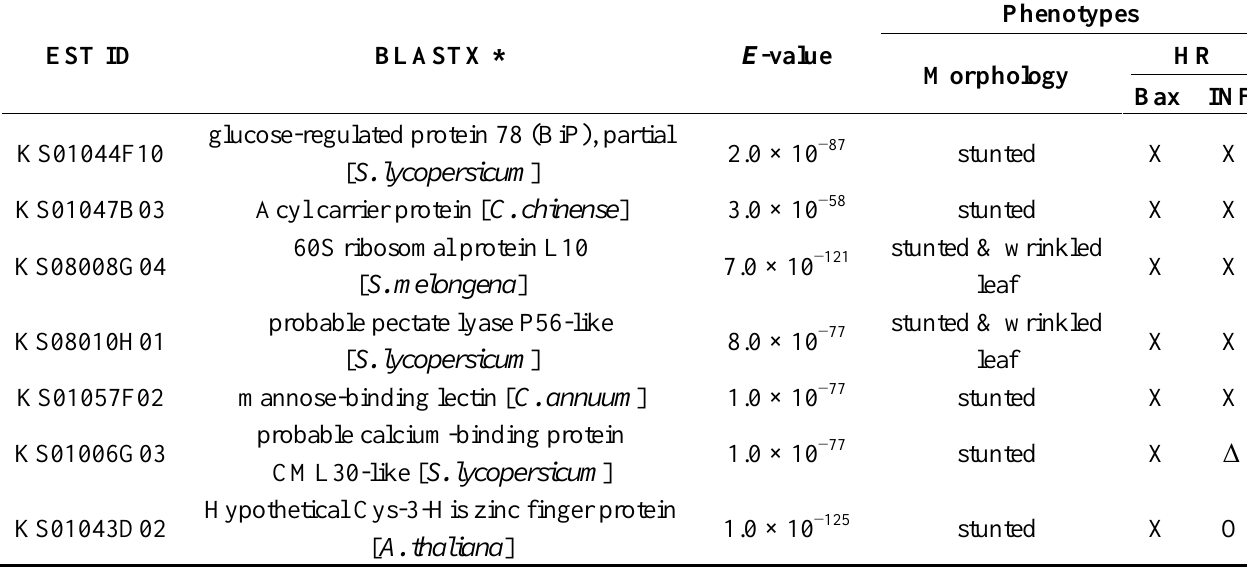
Table 2. Pepper ESTs involved in Bax- or INF1-mediated cell death